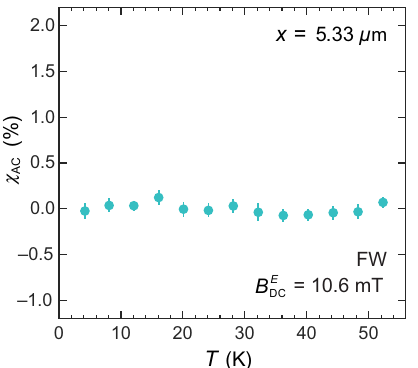
FIG. 12. Coil field versus temperature. The susceptibility χ ac up to 52 K measured for NV centers far from Flake A, represent- ing the bare coil field. It shows no systematic change due to the drift of the coil relative to the sample or the change in the current in the coil in this temperature range.